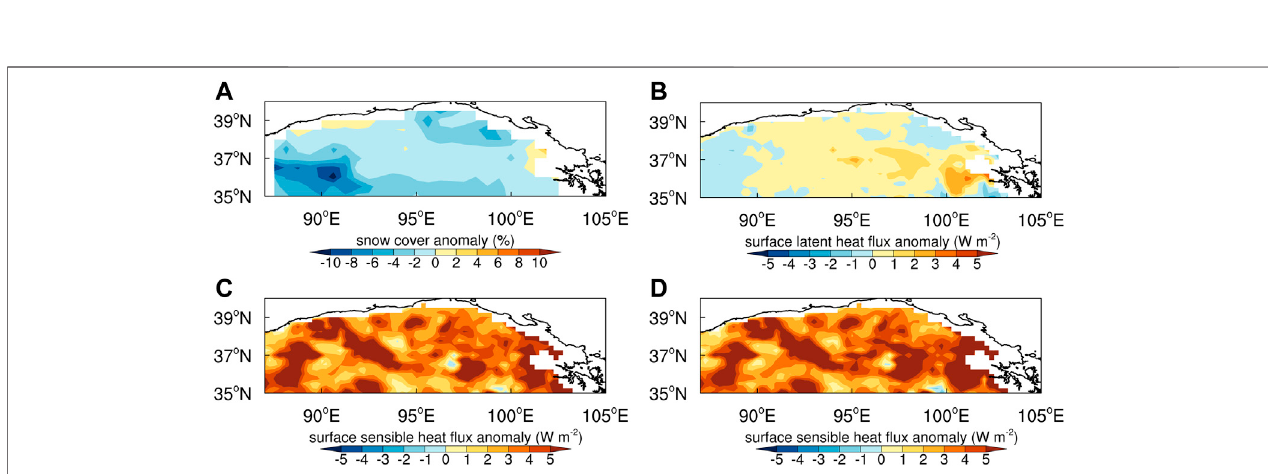
FIGURE 12 | Spatial distribution of (A) snow cover (units: %), (B) surface latent heat fl ux (units: W m − 2 ), (C) surface sensible heat fl ux (units: W m − 2 ), and (D) the surface latent + sensible heat fl ux (units: W m − 2 ) on the difference between low and normal days.